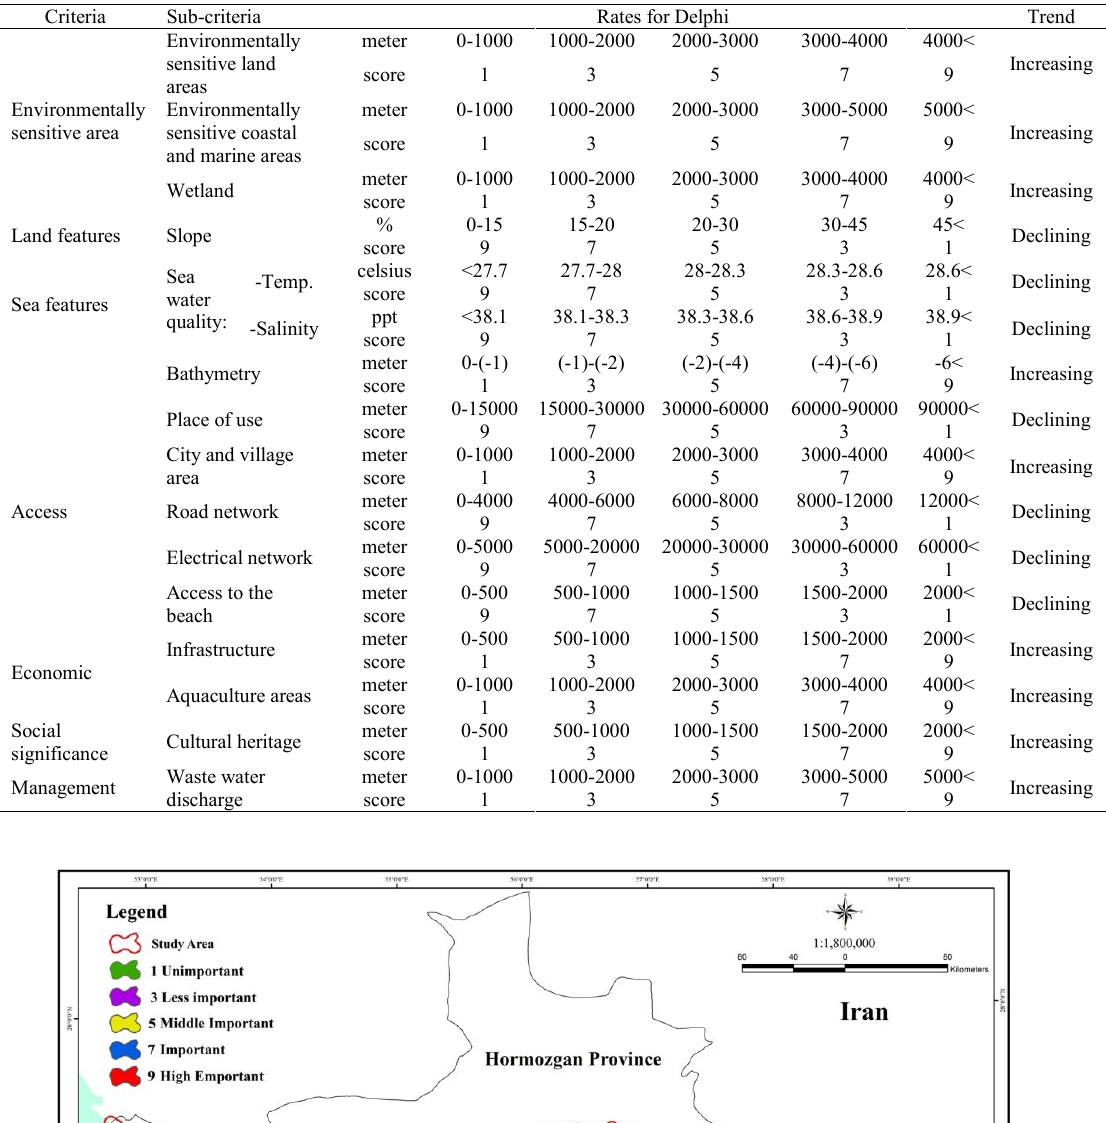
Table 4: Evaluation of the sub-criteria based on distance TrendRates for DelphiSub-criteriaCriteria